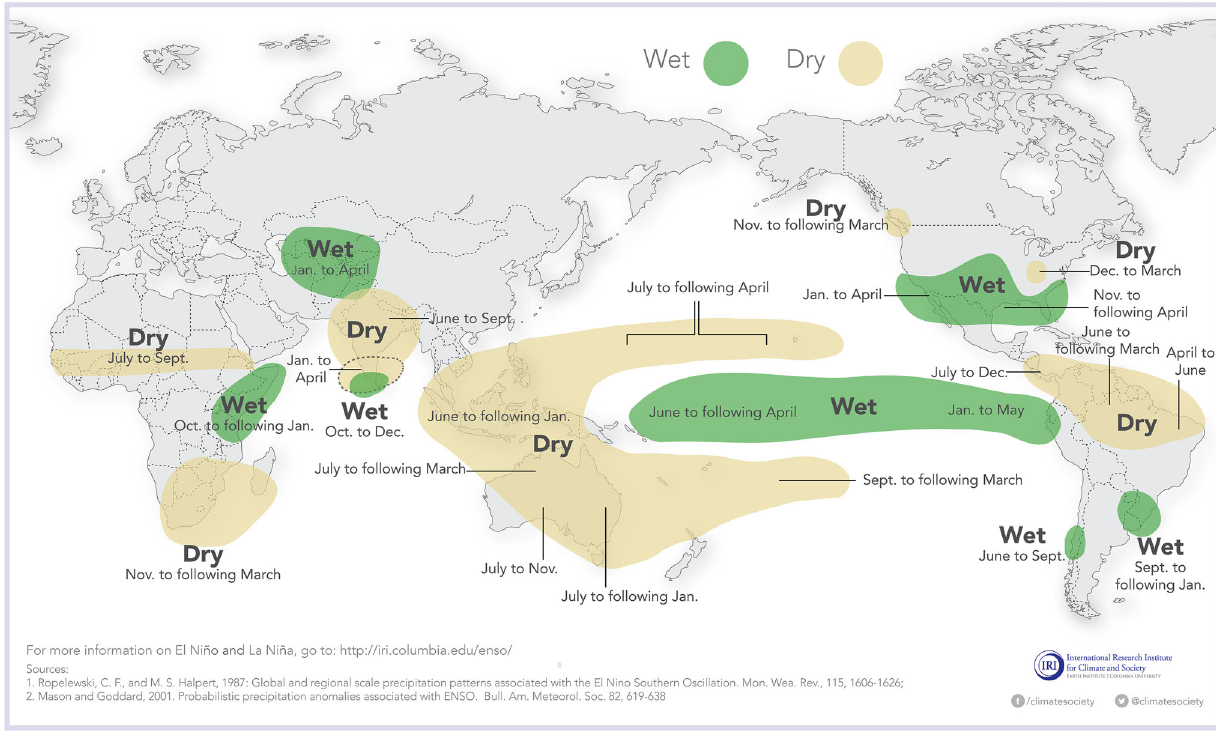
Fig. 1 Map of El Nin˜o-related rainfall patterns in various locations around the globe. Source : IRI (n.d.)